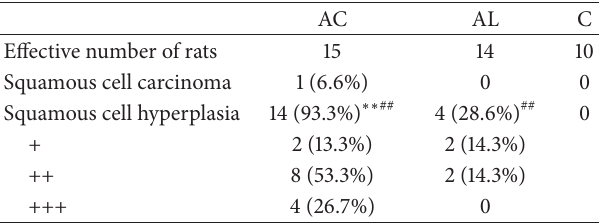
Table 1: Histopathologic findings of hyperplastic changes in the forestomach.